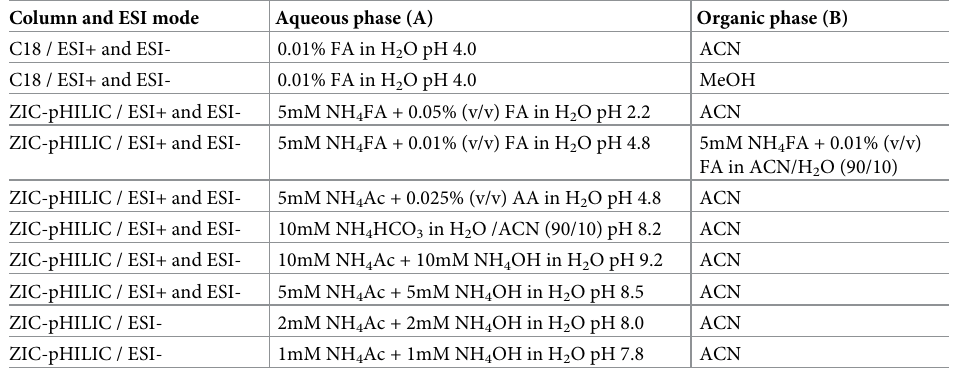
Table 2. Mobile phase conditions evaluated with the C18 and ZIC-pHILIC